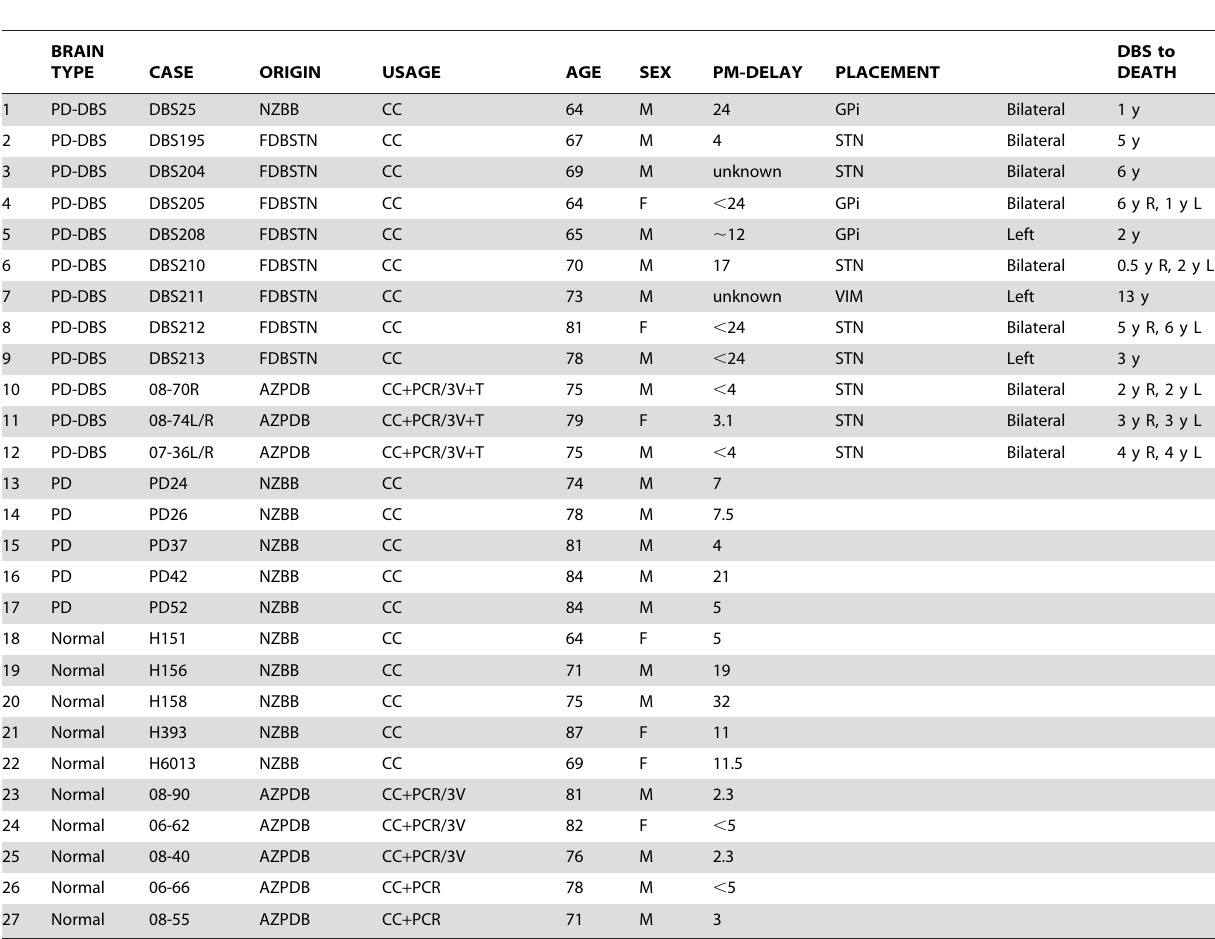
Table 1. Table of cases used in this study showing case number, brain bank the tissue was from, sex, age, stimulator lead placement and side of the brain on which the lead was